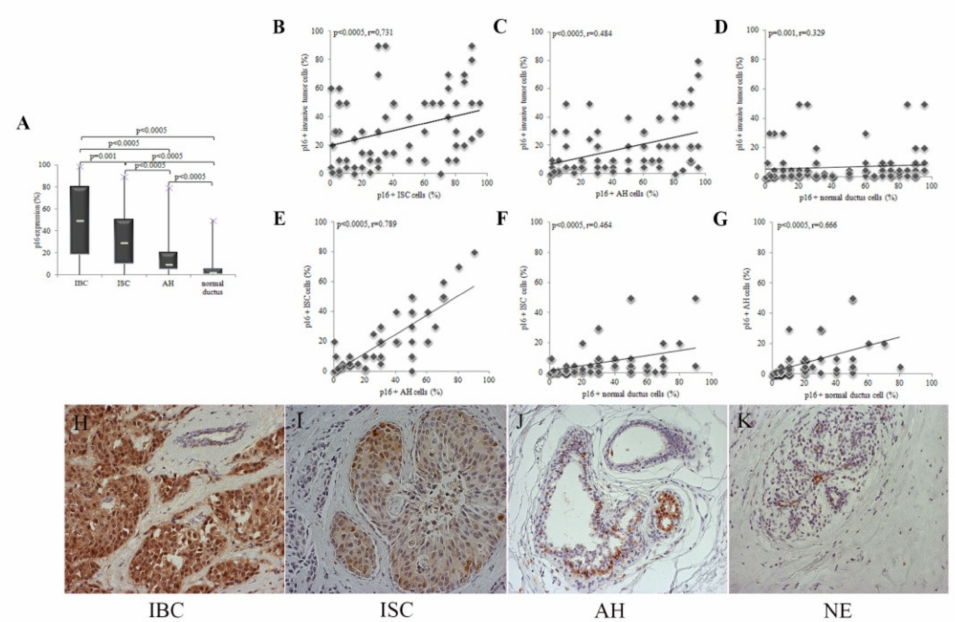
Figure 1. Patients were divided into four groups according to the type of change in the breast: with IBC ( n = 147), ISC ( n = 79), AH ( n = 82), and NE ( n = 109). IHC expression of p16 was quantified in the nucleus and cytoplasm of tumor cells and presented as a percentage of positive in relation to the total number of evaluated cells. ( A ) The expression of p16 is significantly higher in IBC compared to NIL ( p < 0.0005). The result is shown as the median. Statistical significance was analyzed using the Kruskal–Wallis and Mann–Whitney tests. ( B – D ) The increase in expression in IBC was accompanied by an increase in expression in ISC, AH, and NE. ( E , F ) Increased p16 expression in ISC was accompanied by increased expression in AH and NE. ( G ) Increased expression of p16 in AH is accompanied by an increase in expression in NE. Statistical significance was analyzed using the Spearman correlation coefficient. IHC expression of p16 in various lesions in the breast: ( H ) IBC.